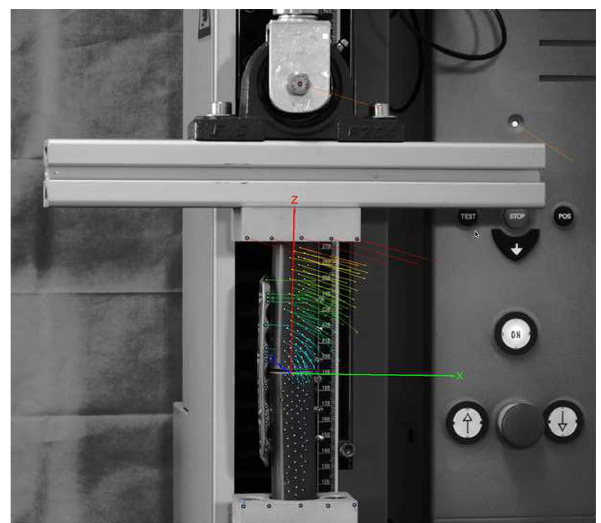
Figure 5. Test set-up. Axial load was applied by a universal testing machine. 3D-motion at the fracture gap was measured with an optical motion analysis system and visualized by vectors. Raw data of the 3D- motion of every passive marker was analyzed using the software MATLAB.